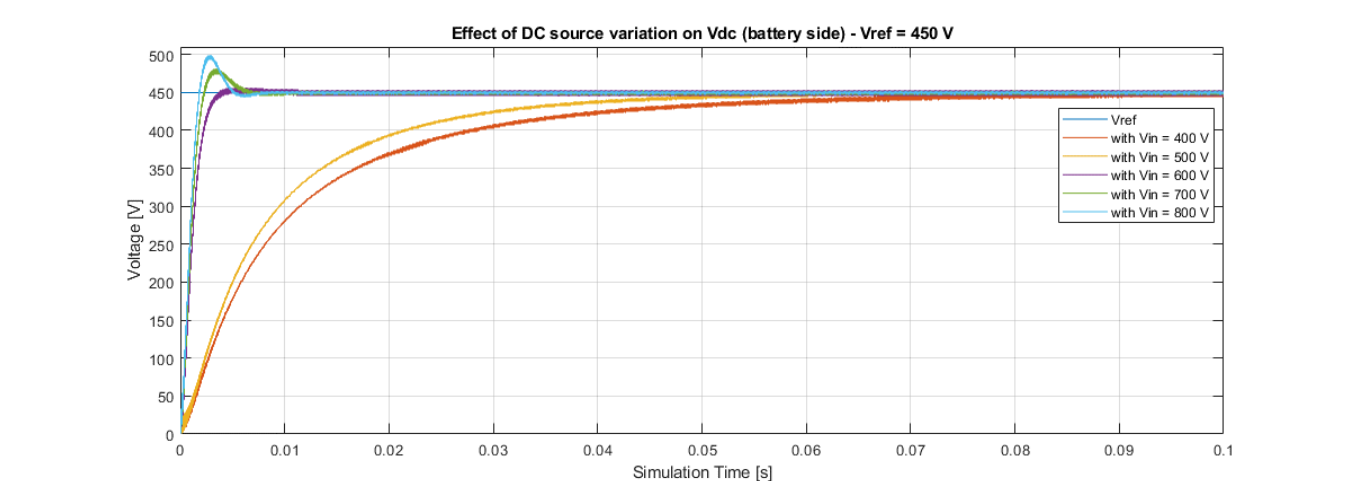
Figure 24. Effect of the V in variation on the output voltage control in the DAB converter, with V ref = 450